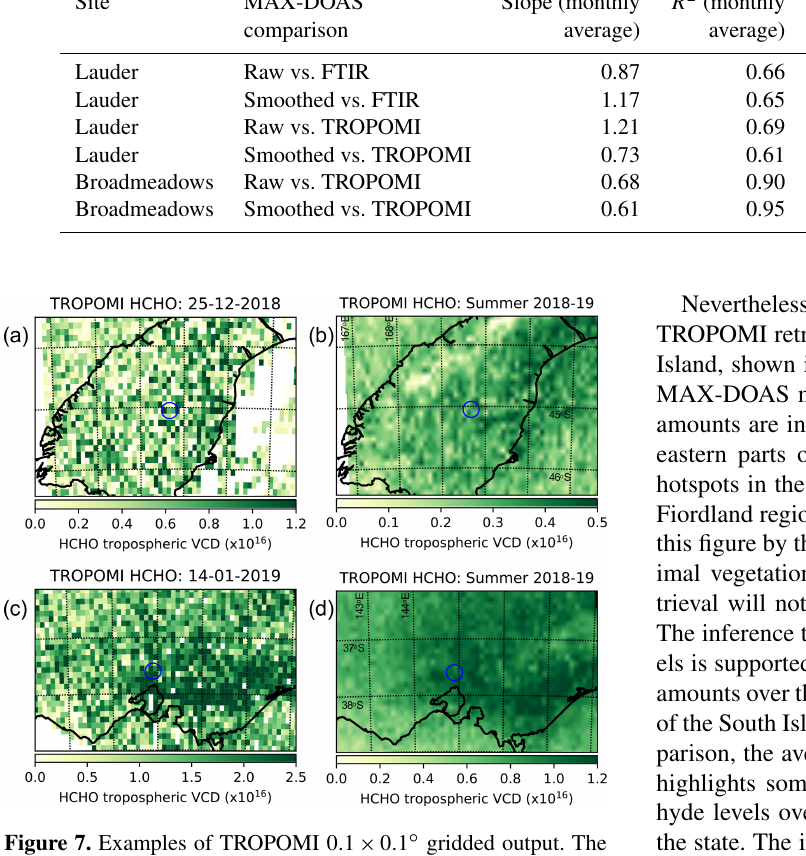
Figure 7. Examples of TROPOMI 0 . 1 × 0 . 1 ◦ gridded output. The blue circles indicate the MAX-DOAS measurement locations. The grid lines drawn are at 1 ◦ latitude and longitude intervals. (a) Exam- ple retrieval from the South Island of New Zealand, 24 December 2018; (b) all New Zealand retrievals from December 2018 to Febru- ary 2019 averaged. (c) Example from Victoria, 14 January 2019; (d) all Victorian retrievals from December 2018 to February 2019 averaged. Note that the colour bar scale is different for each plot to emphasize the spatial